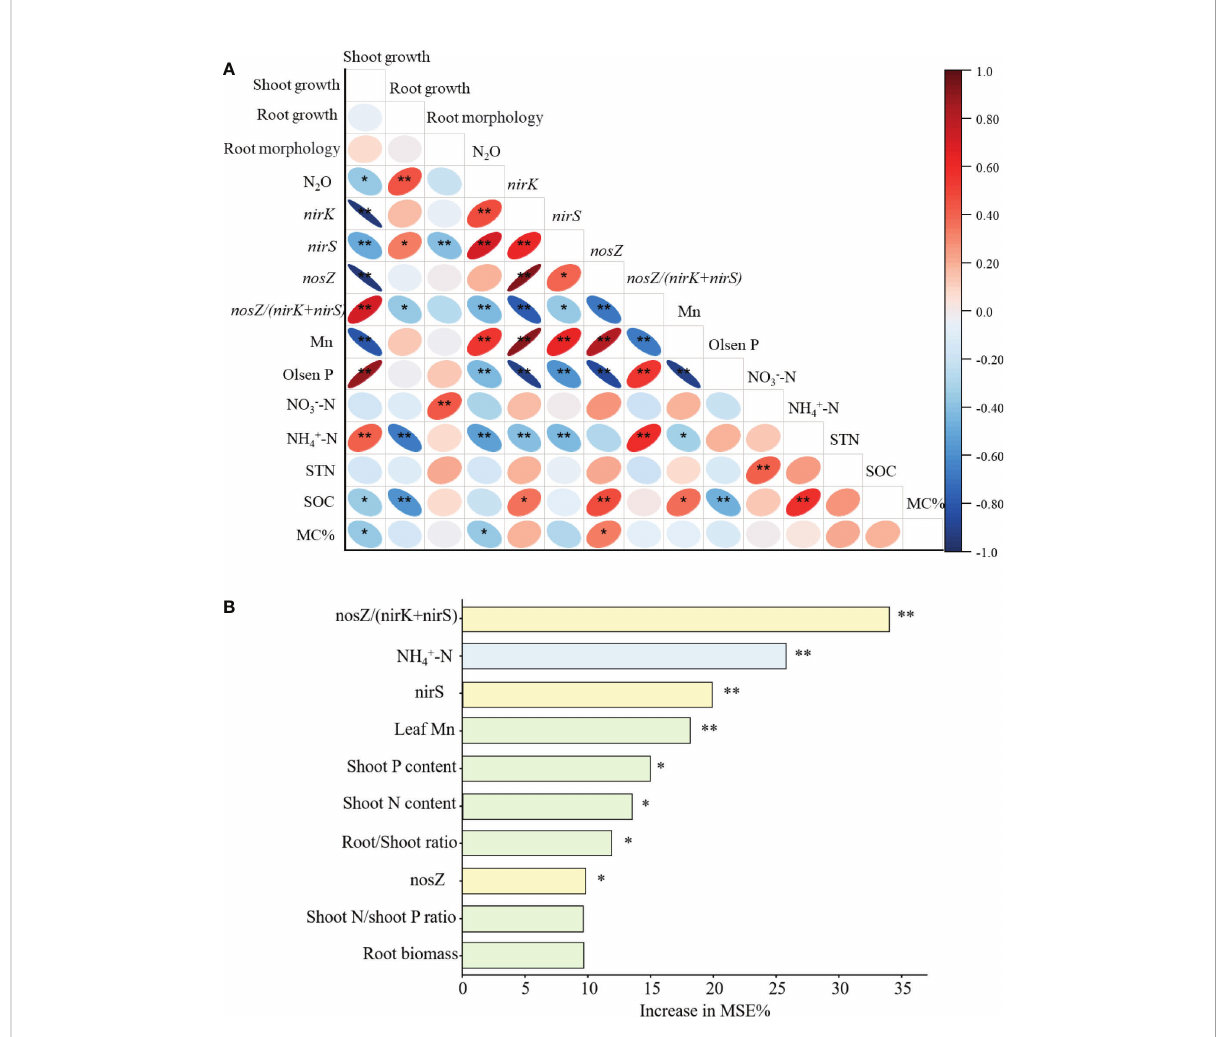
FIGURE 5 (A) Heat map of Pearson ’ s correlation coef fi cients with original data among N 2 O emission, gene copies, plant traits and soil properties. (B) Random Forest for importance of the speci fi c variables to N 2 O emission. The variables were sorted in the decreasing order of the importance value. **P < 0.01 and *P <